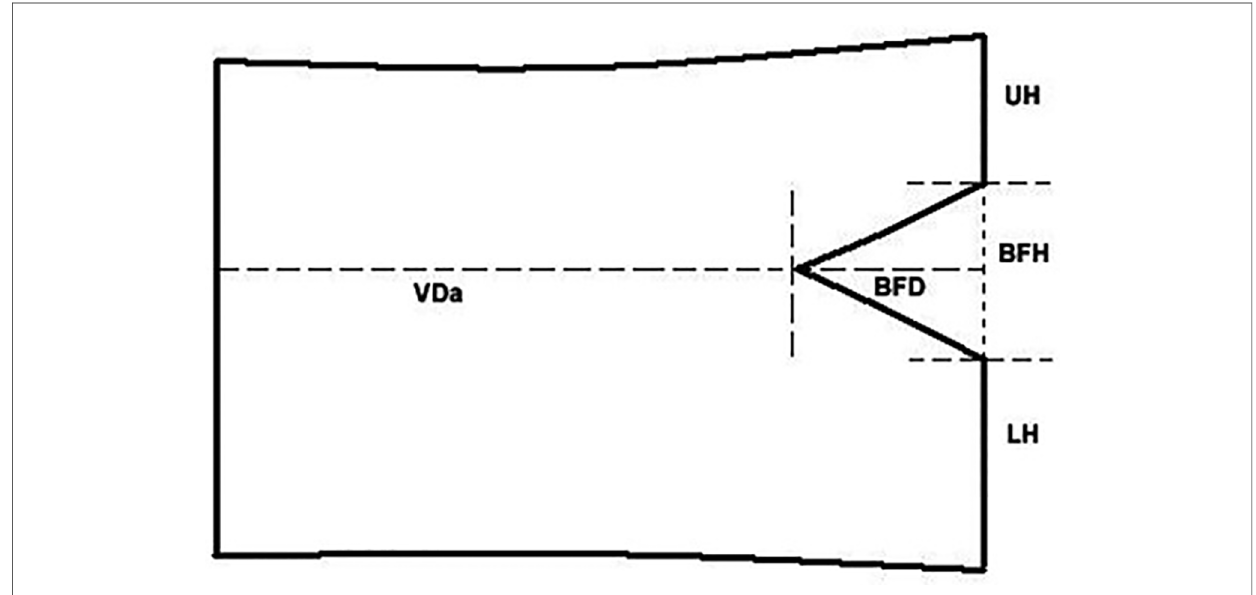
FIGURE 2 BFs ’ parameters in a drawing of VB. The BFH is the distance between the two crossover points of BF and posterior wall of VB. The BFD is the distance of anterior point of BF to the line crossing the two crossover points. Along the line, the distance of the upper crossover point to the upper endplate called UH, and the distance of the lower crossover point to the lower endplate called LH. The distance of anterior point of BF to the anterior margin of VB is